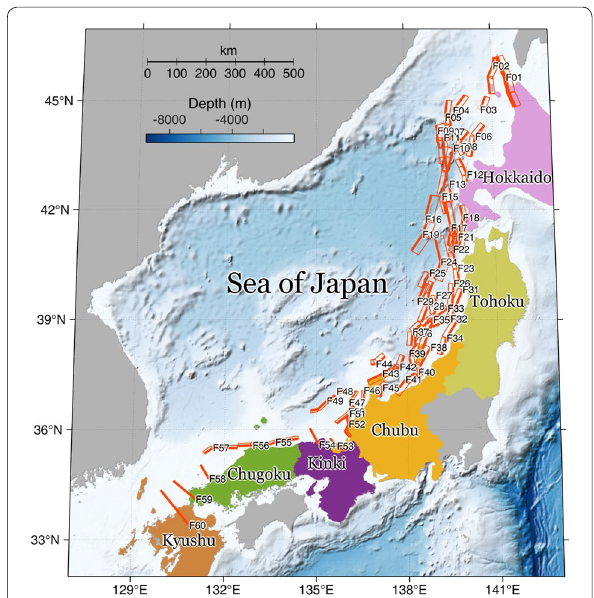
Fig. 1 Study area. Faults are drawn in red with bold lines mark the top edge of faults, and annotations from F01 to F60 indicate fault names. Six regions considered in the study are shown by different